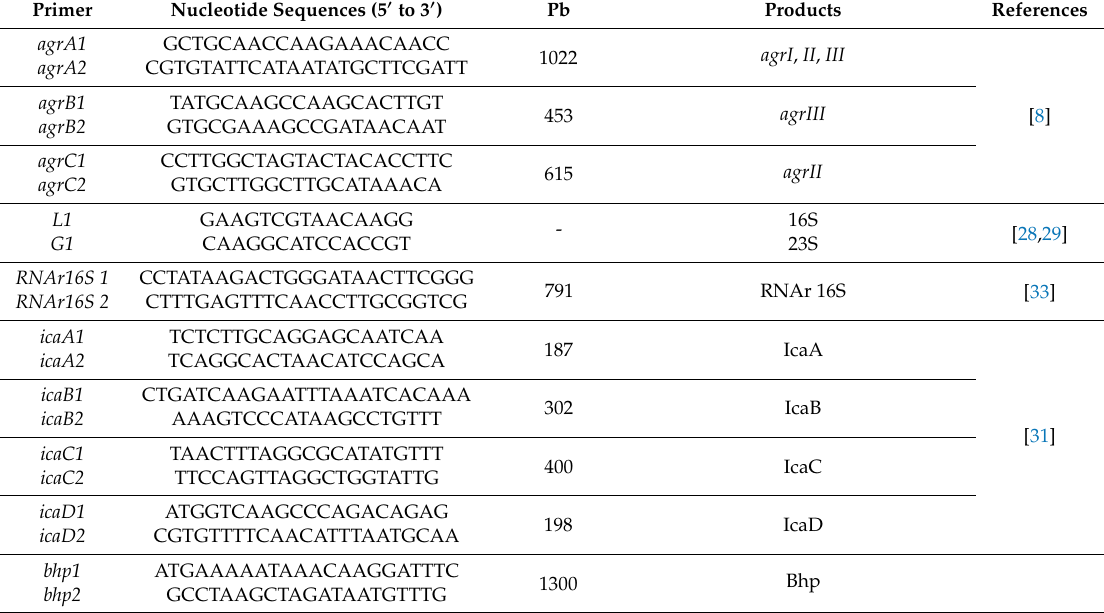
Table 5. Oligonucleotides used in PCR techniques for genotypic identification, mec A gene, biofilm and SCC mec